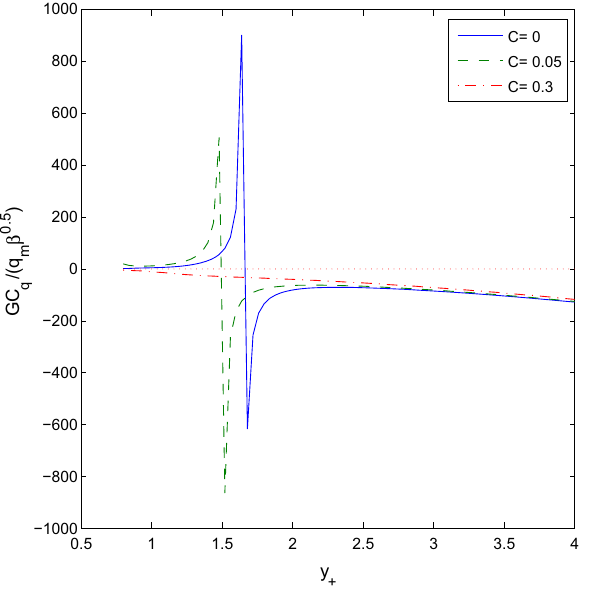
√ β) vs y + .Thedashedcurve Fig. 5 The plot of the function GF /( curve corresponds to C = 0 . 1, the solid curve is for C = 0, and the dash-dotted curve corresponds to C = 0 .